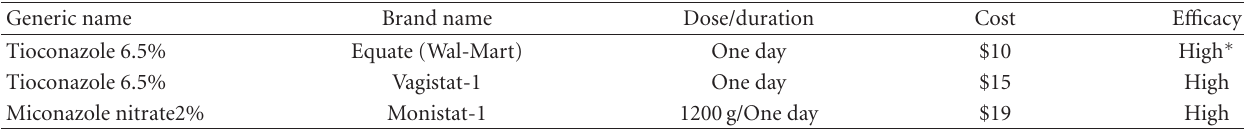
Table 1: Intra-vaginal Imidazoles. One-day treatments.